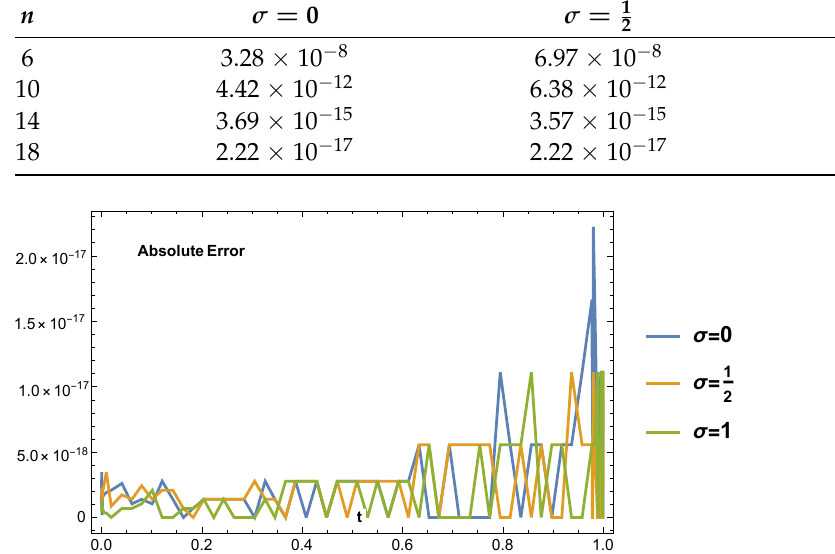
Figure 3. The absolute error graph of Example 2, for α = β = ρ = 1 and n =